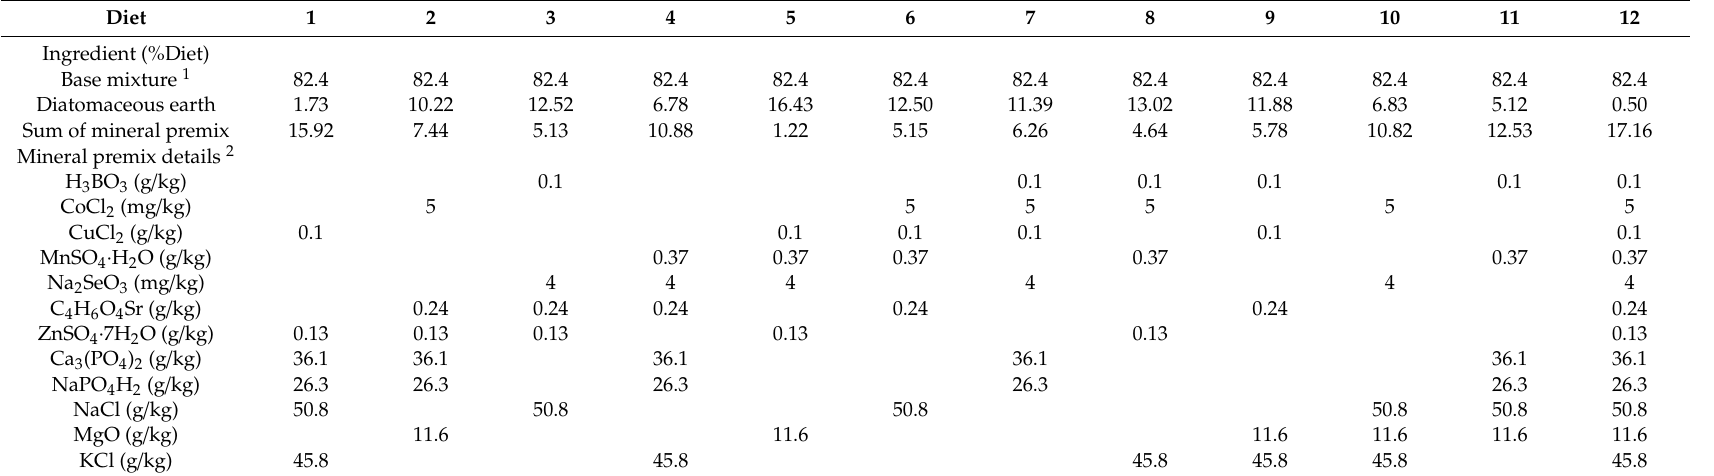
Table 2. Dietary composition of casein and wheat starch-based diets for